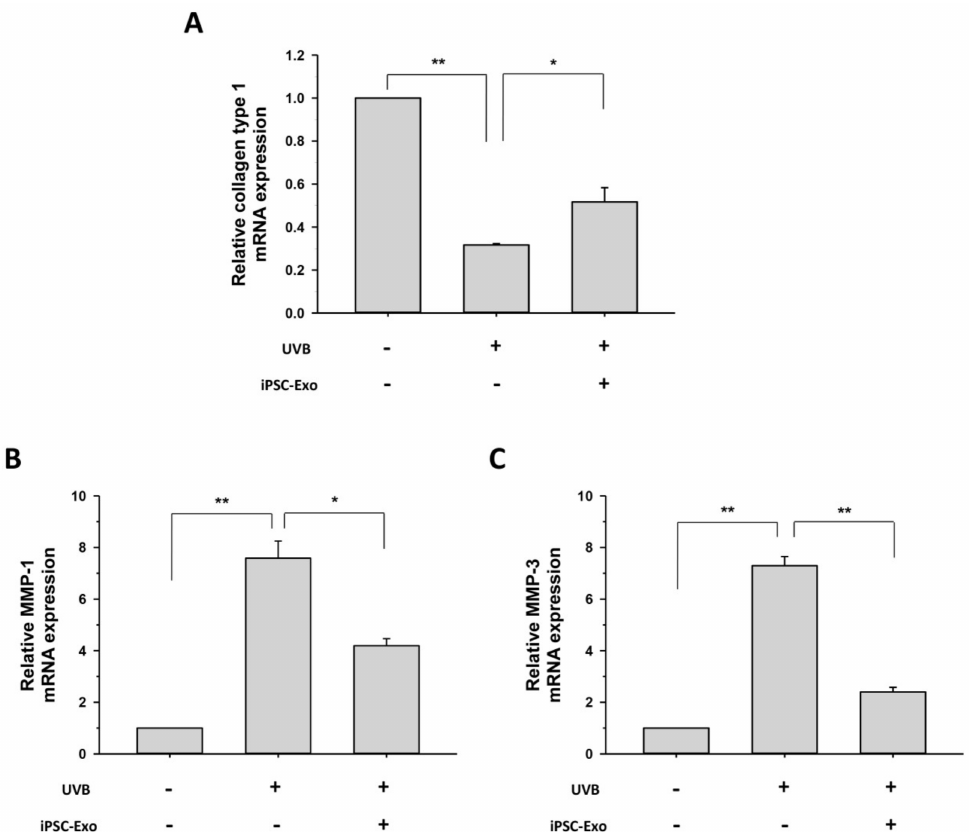
Figure 5. iPSC-Exo restored the altered expression of specific dermal markers in UVB-irradiated HDFs. After treatment with 20 × 10 8 particles/mL iPSC-Exo for 24 h in serum-free DMEM/F12, HDFs were harvested after 48 h. The mRNA expression levels of collagen type I ( A ); MMP-1 ( B ); and MMP-3 ( C ) were quantified by quantitative real-time RT-PCR. * p < 0.05, ** p < 0.01. Error bars indicate standard deviations of triplicate samples in a single representative